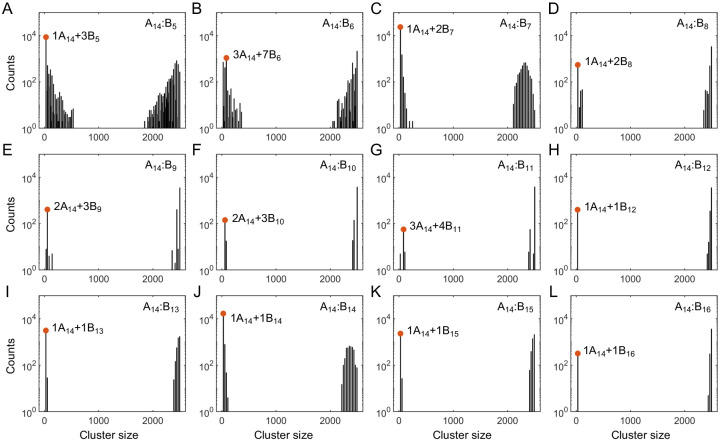
Histograms of cluster size in stickers in (A–L) A14:B5-16 systems at equal global sticker stoichiometry.Parameters: specific binding strength U0=14⁢kB⁢T and total global sticker concentration 6.64 mM. Red dots indicate the dominant oligomer in the dilute phase.